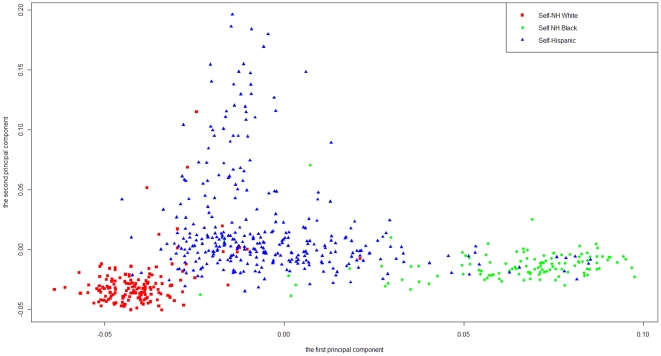
Scatter-plot of the first and second principal components.Scatter-plot of the first and second principal components calculated from the genotypes of 213 AIMs. The first principal component scores showed good separation between the self-reported non-Hispanic white and self-reported non-Hispanic black groups, while the principal component scores of self-reported Hispanic group were in-between.